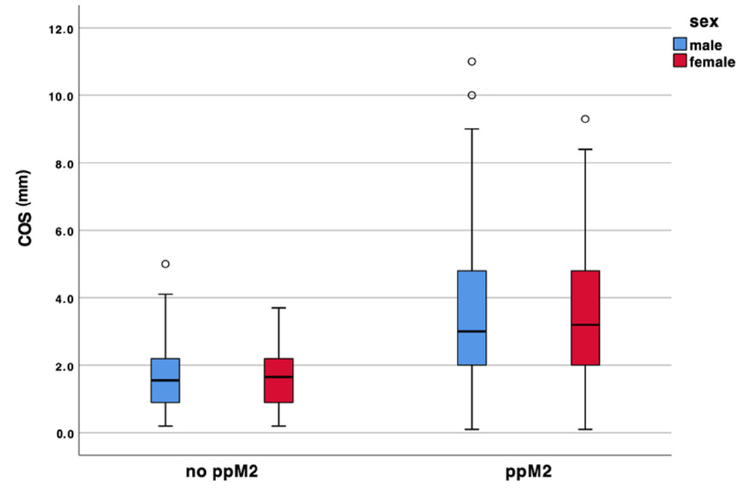
Figure 3. COS depth and gender.